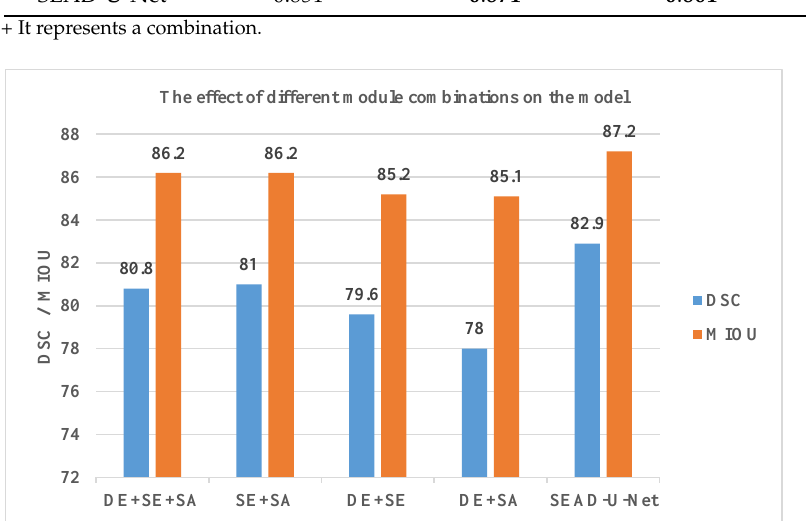
Figure 11. The influence of different modules on model DSC and